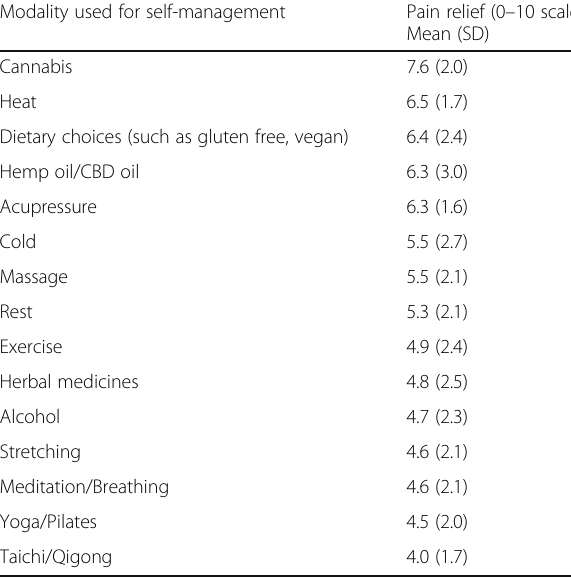
Table 3 Level of self-reported pain relief from self-management modalities, listed from greatest to smallest reported pain reduction